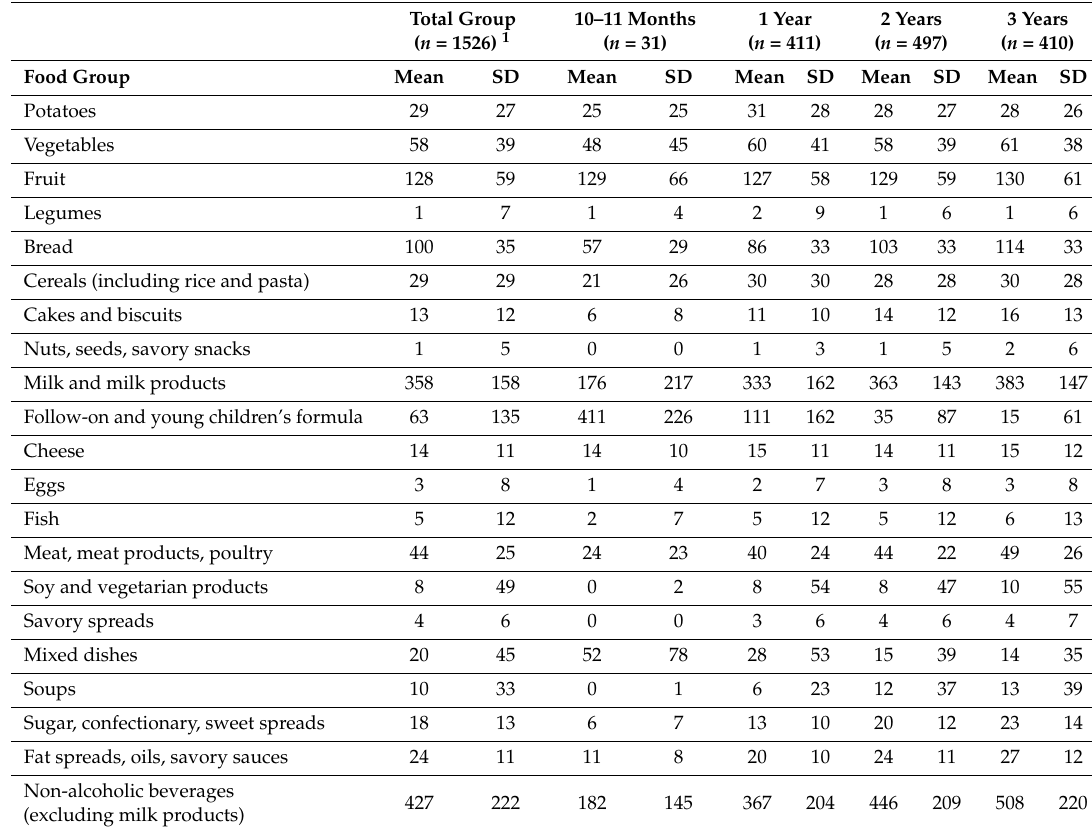
Table 3. Mean daily consumption of food groups (g) by children attending childcare by age (mean of 2